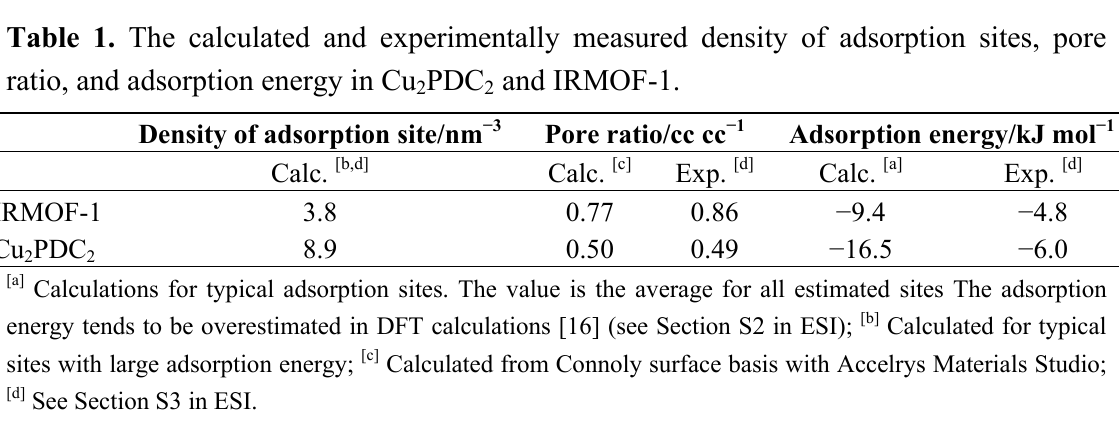
Table 1. The calculated and experimentally measured density of adsorption sites, pore ratio, and adsorption energy in Cu